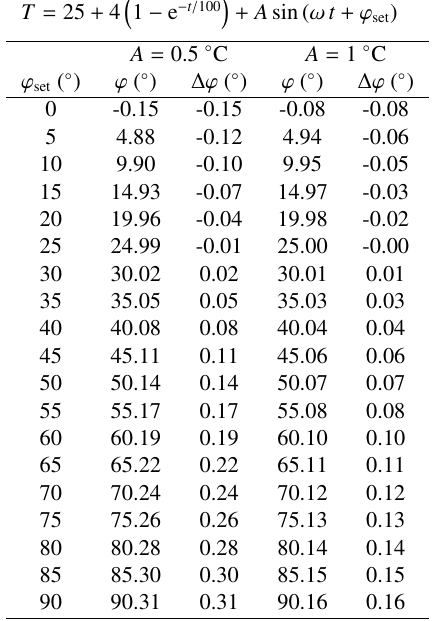
Table 3. Deviations in processing a harmonic signal with frequency 0 . 1 Hz ( ω = 2 π 0 . 1s − 1 ) superposed on an exponential function with standard deviation of 0 . 2 ◦ C for amplitude A = 0 . 5 ◦ C. Sample frequency 10 Hz, signal length 100 s. The results for a non-rounded signal are shown in the columns on the left. The results for a signal with quantum resolution of 0 . 1 ◦ C are shown in the columns on the right.